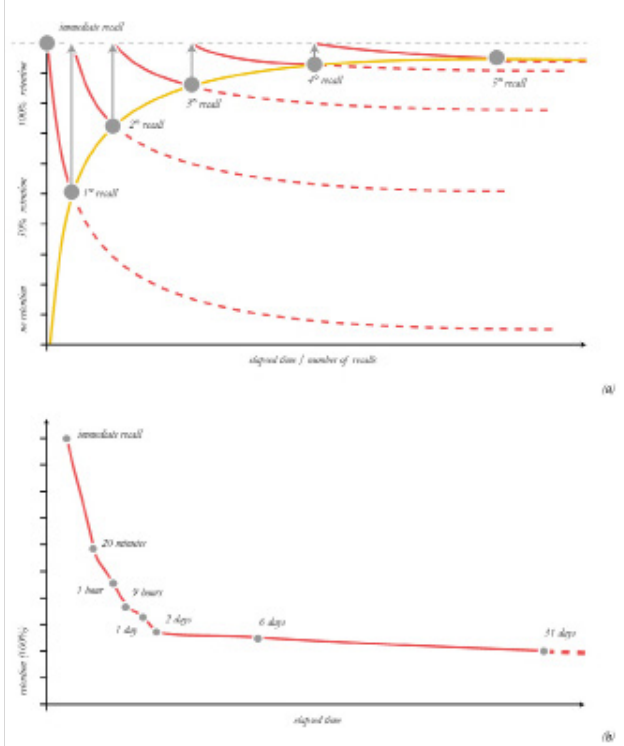
Fig. 3 Zambonini A., the graph (a) shows the correlation between each recall and the retention percentage, while the graph (b) represents